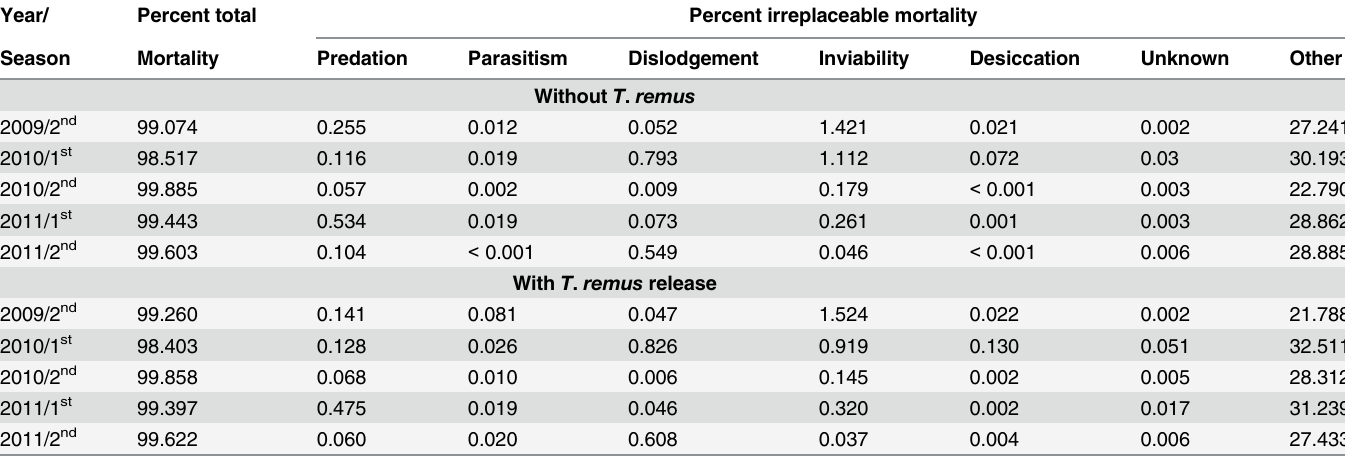
Table 5. Total percentage mortality and irreplaceable mortality by year and seasons when considering egg and larval mortality together in maize fields without and with Telenomus remus